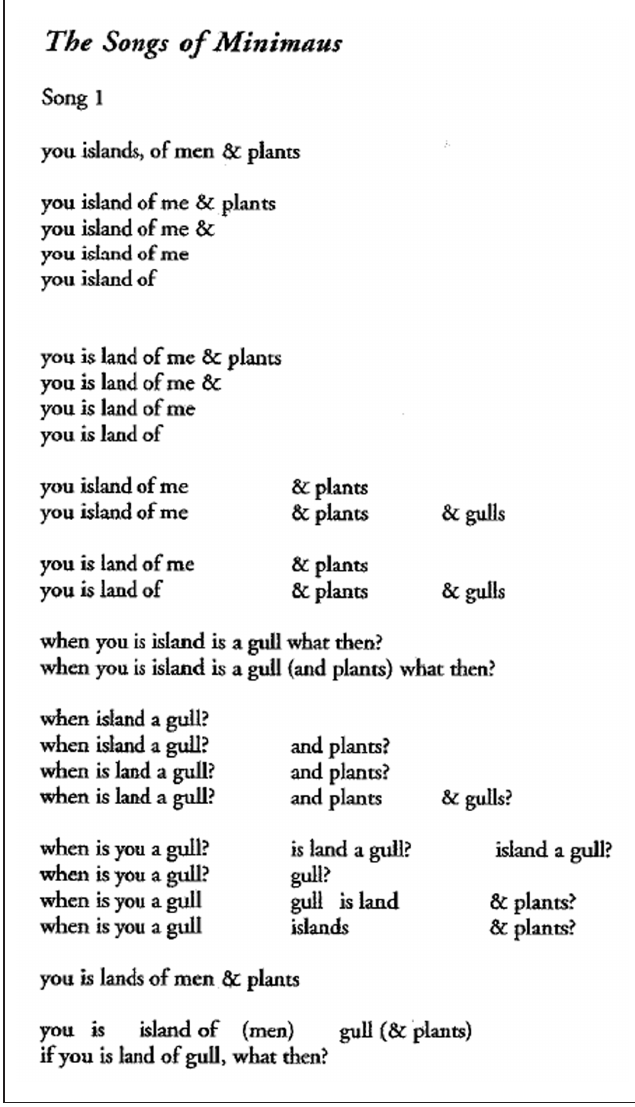
Figure 3: Redell Olsen, “The Songs of Minimaus: Song 1.”